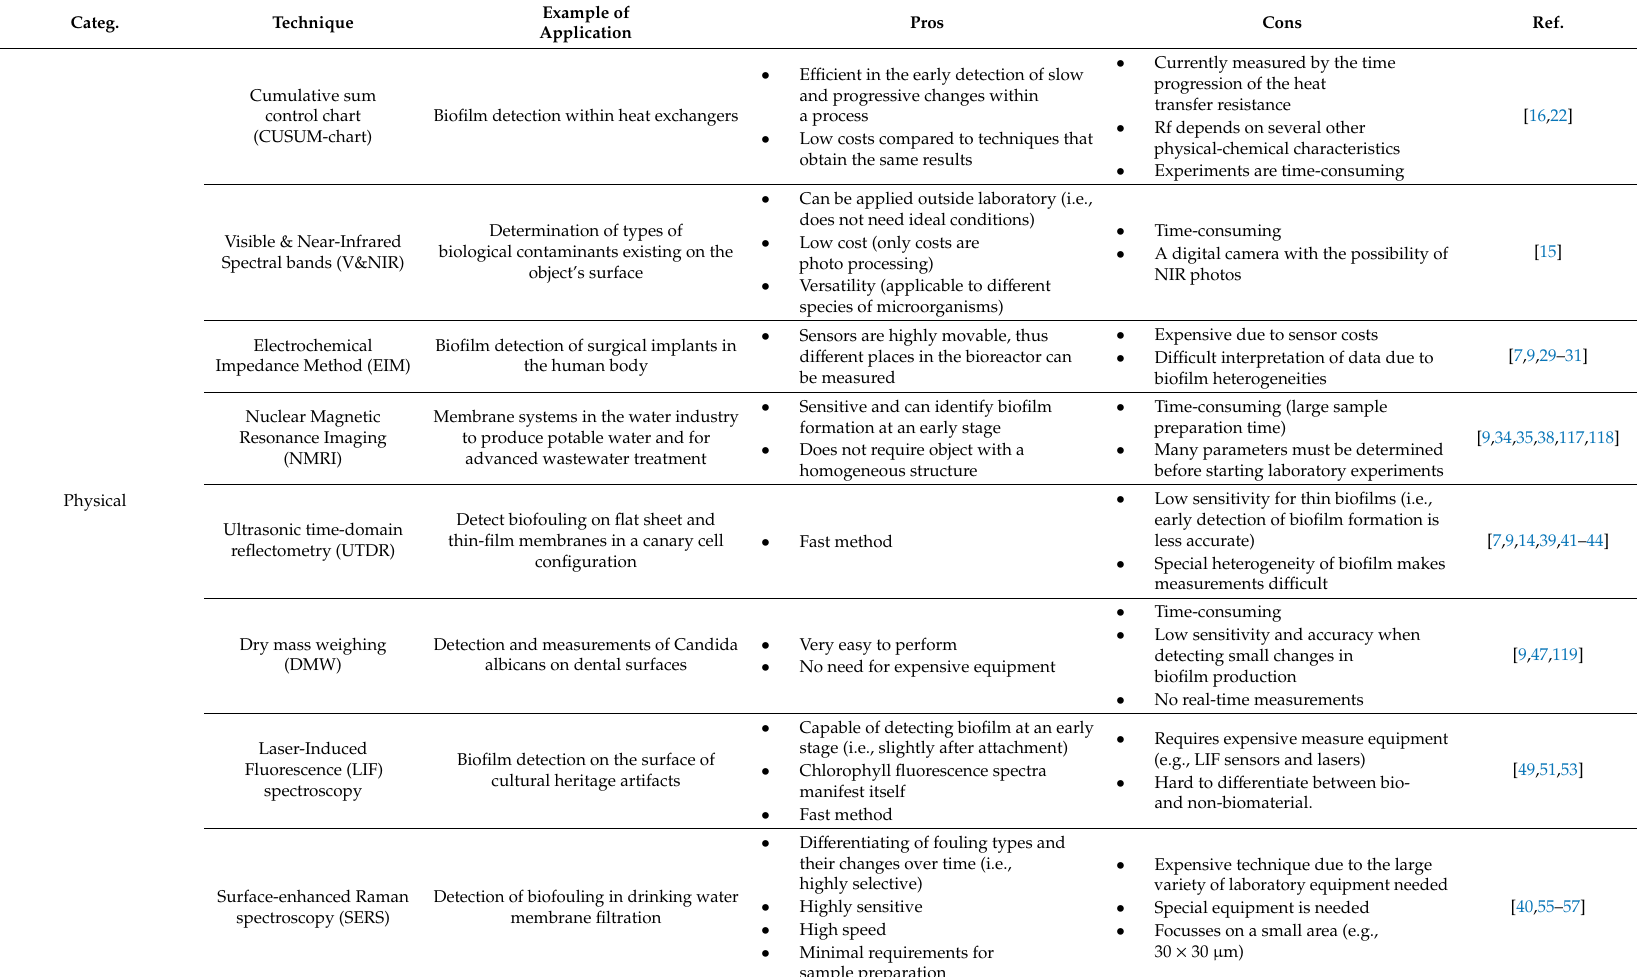
Table 1. Indicative biofilm detection and / or measuring techniques and their advantages and drawbacks based on the literature.